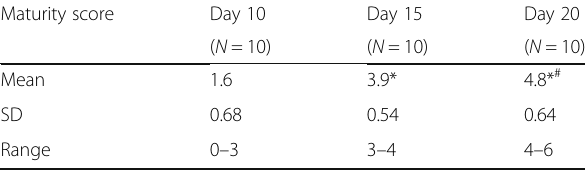
Table 2 Summary of the maturity scores between the groups Maturity score